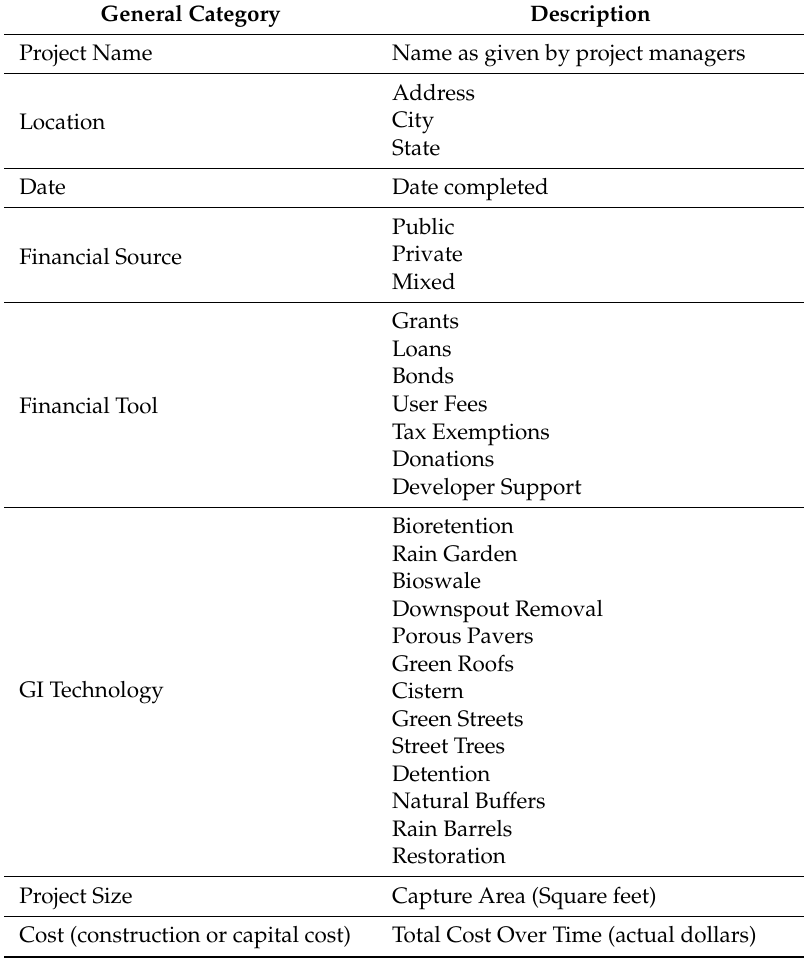
Table 1. Parameter list from the ASLA convenience